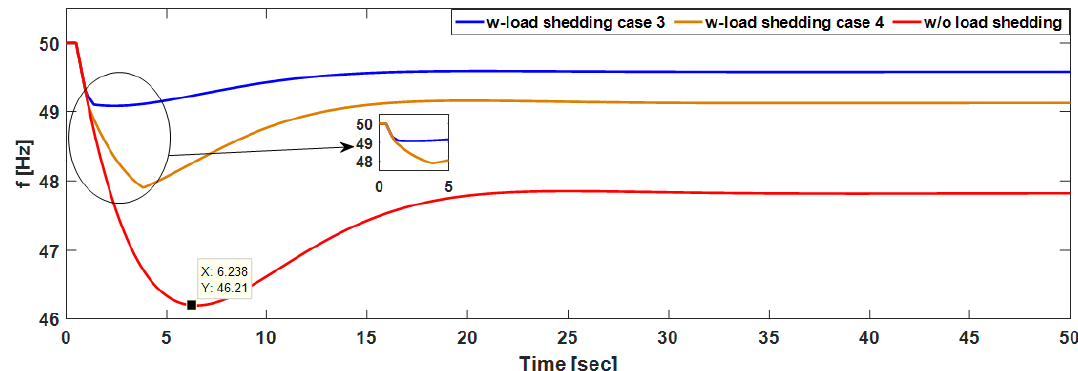
Figure 7. Frequency behavior in the second scenario: a comparison between cases 3 & 4.